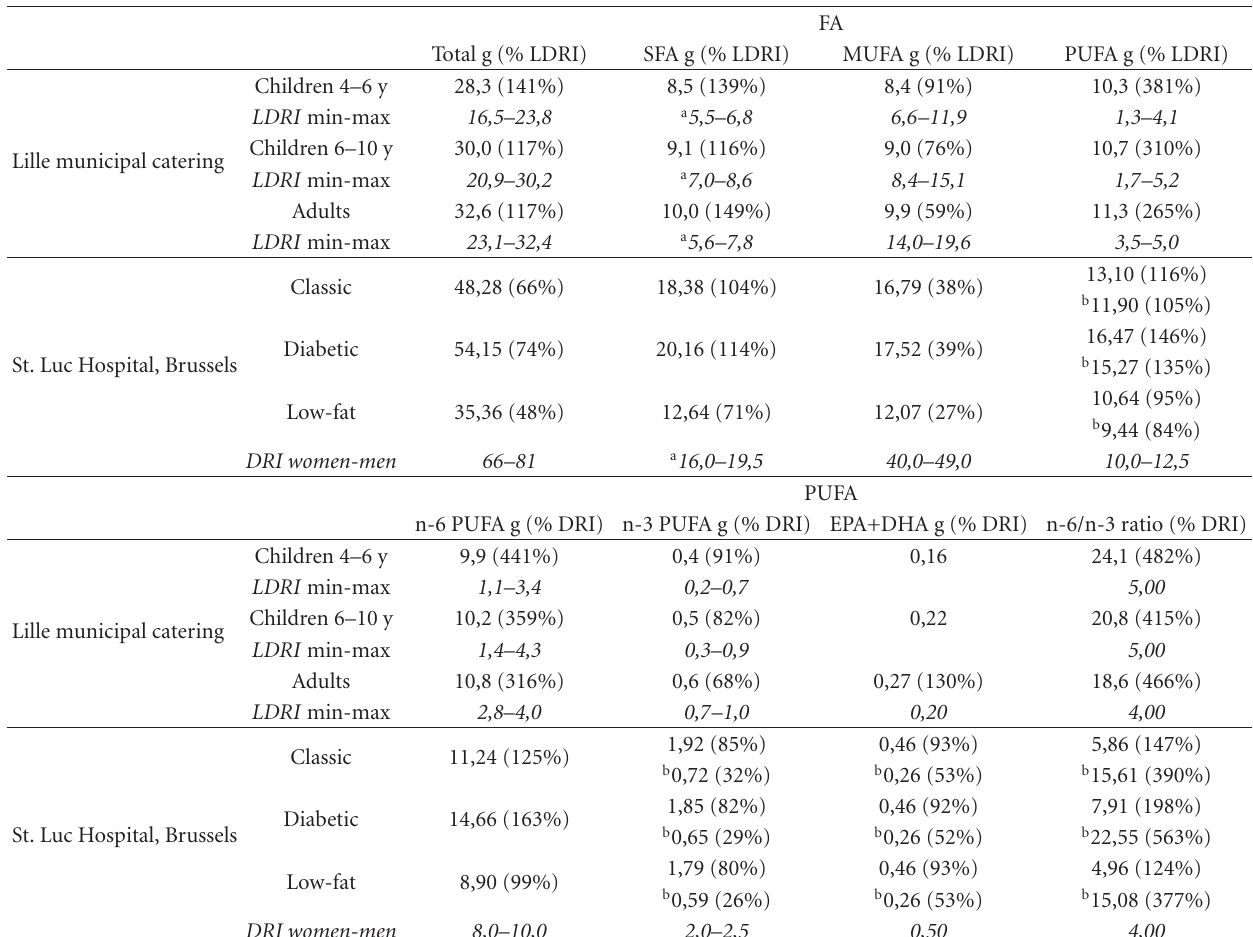
Table 1: Daily fatty acids supplies in municipal and hospital